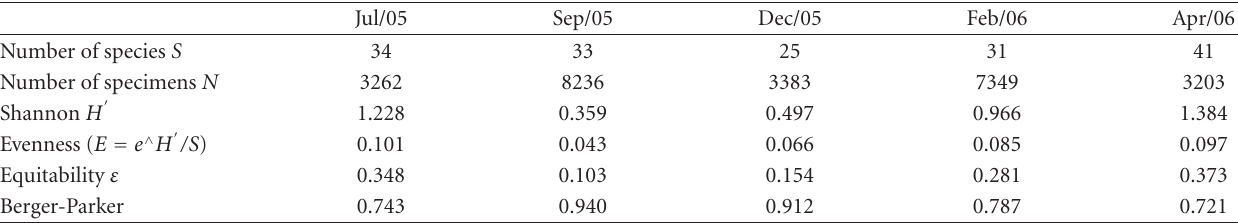
Table 2: Diversity indices for culicid specimens-temporal samples.